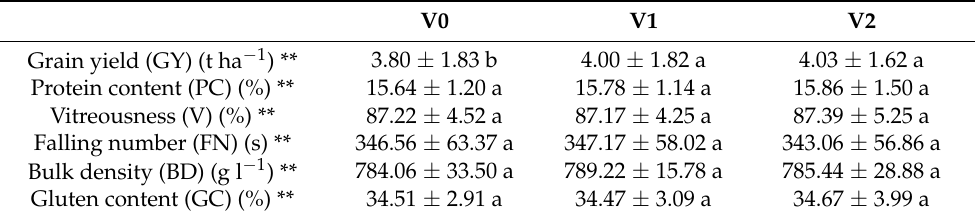
Table 3. Yield components of durum wheat in control and in the biostimulant treated variants. Lower case letters (a, b) indicate the significant differences among the variants determined by Tukey’s HSD test, included is also standard deviation ( ± SD). ** α = 0.01 indicate level of